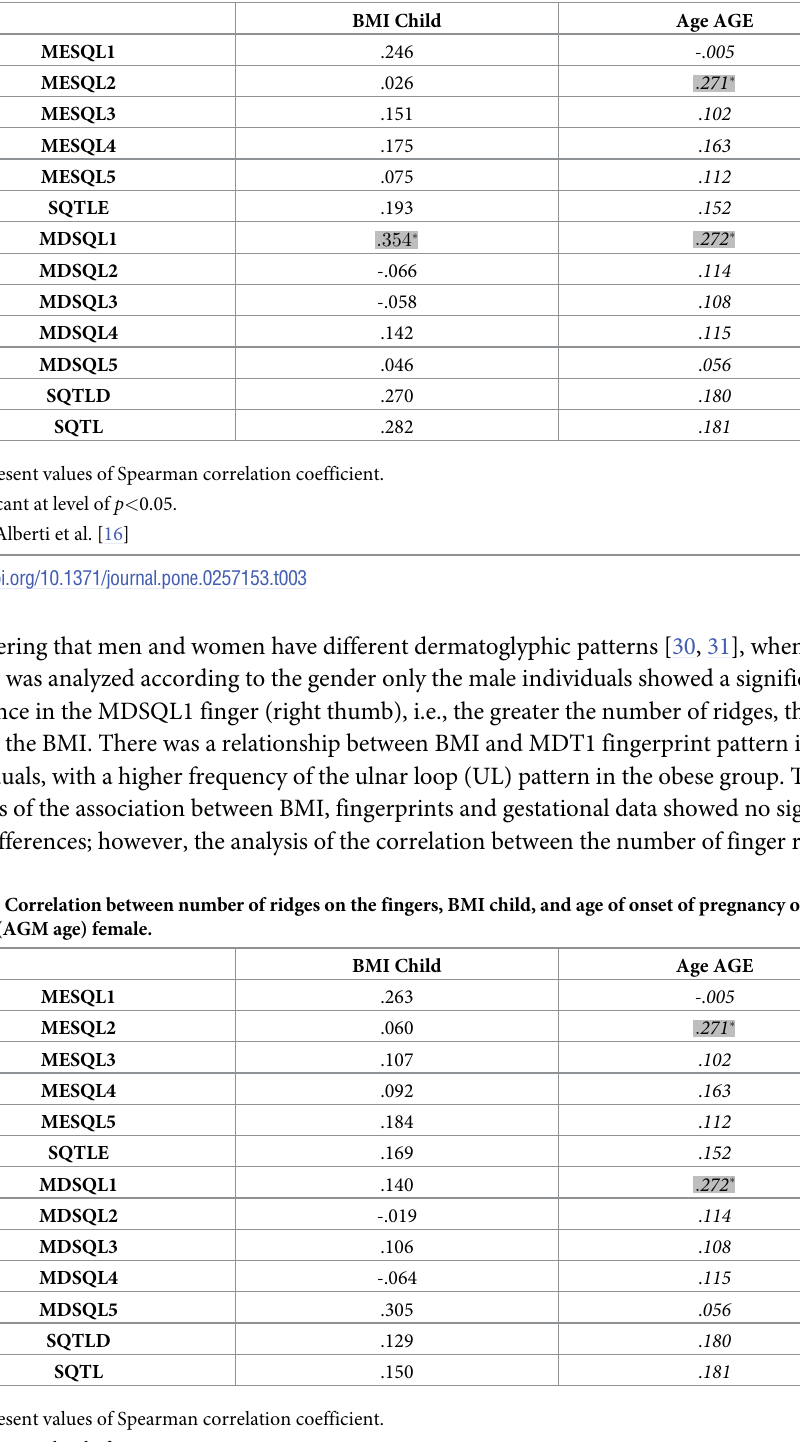
Table 3. Correlation between number of ridges on the fingers, BMI child, and age (AGM age) male (at onset of pregnancy).